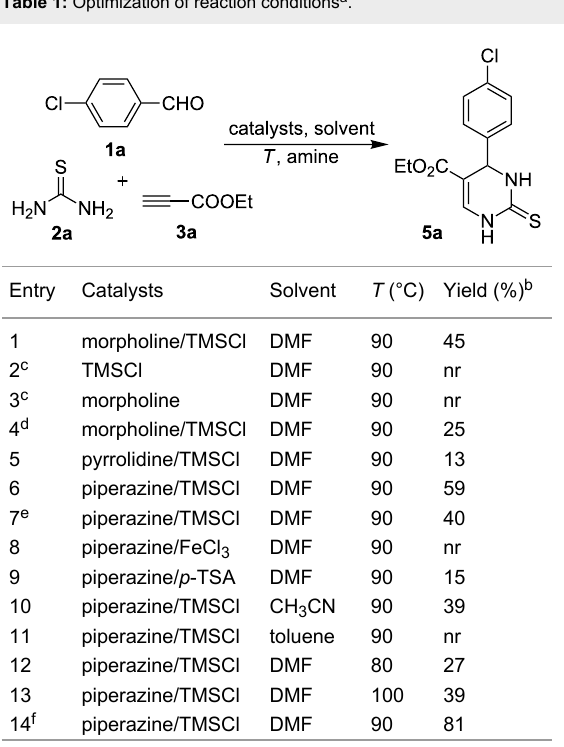
Table 1: Optimization of reaction conditions a . Table 2: Multicomponent synthesis of different DHPMs.